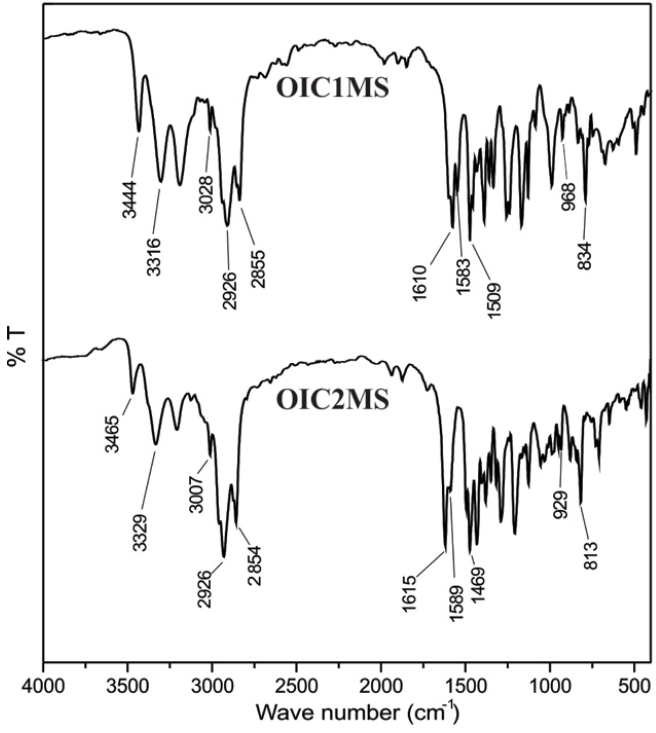
Figure 1. FTIR spectra of oligoimines.